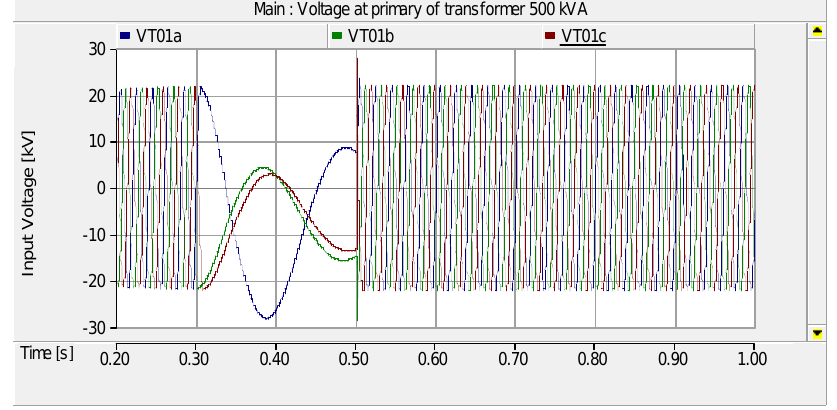
Figure 16. The three-phase circuit breaker disconnecting and connecting without the saturation transformer 500 kVA at the HV side.